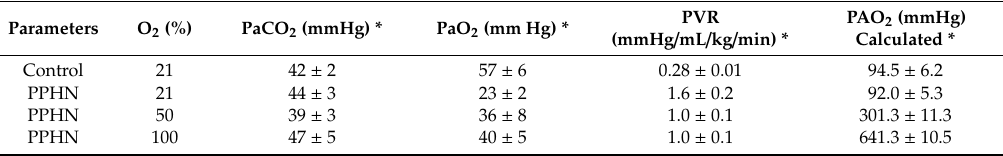
Table 1. E ff ect of PAO 2 on control and PPHN ovine models on PVR [12]